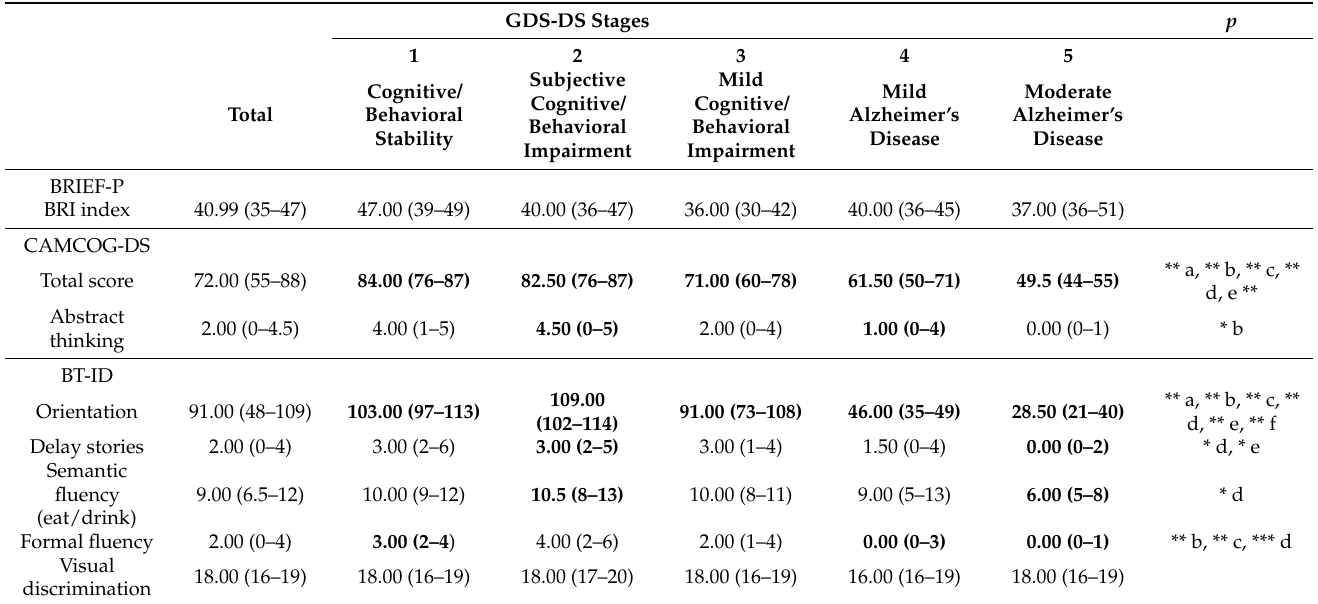
Table 7. Cognitive and behavioral performance across the GDS-DS